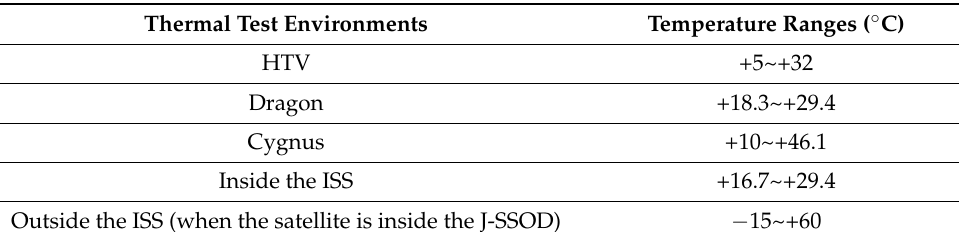
Table 18. Light-1 thermal vacuum test conditions [3]. Thermal Test